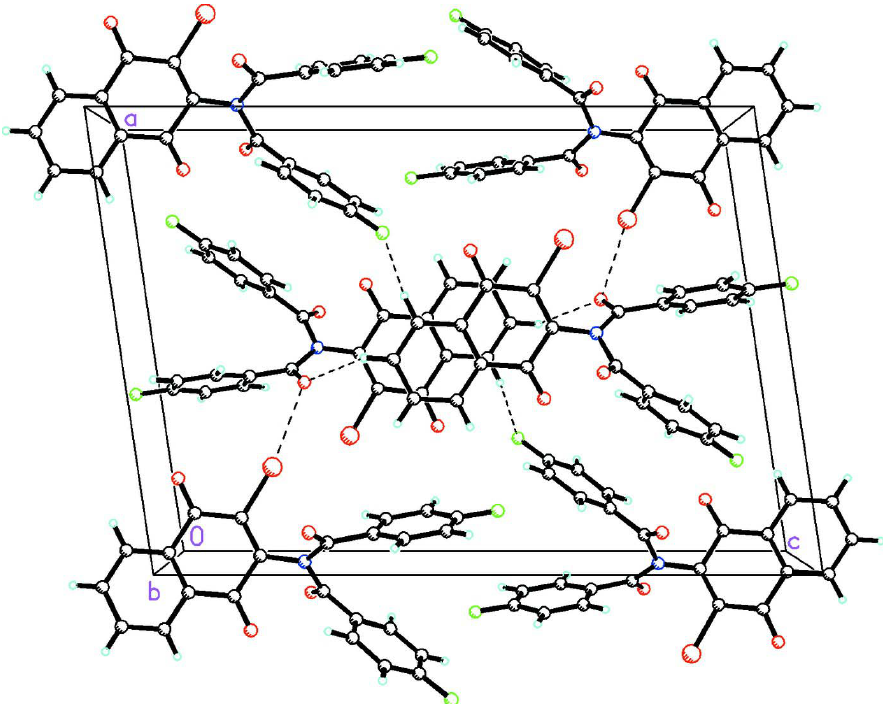
Figure 2 View of the packing viewed down the a axis. Dashed bonds show weak C—H···F interactions as well as the close Br···O intermolecular